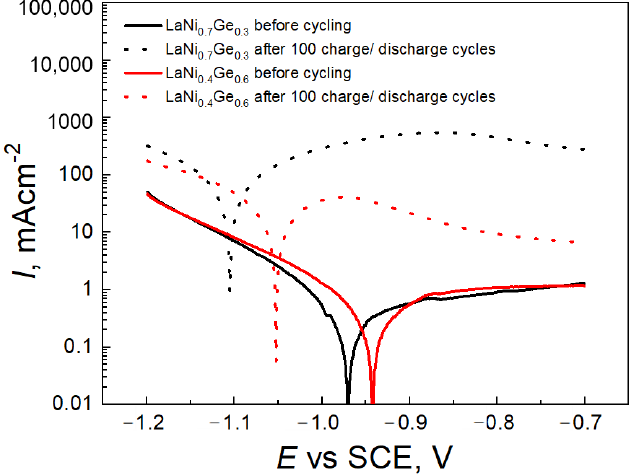
Figure 10. Polarization curves of composite electrodes recorded in 6 M KOH solution at a scan rate of 1 mV s –1 before and after 100 charge/discharge cycles.